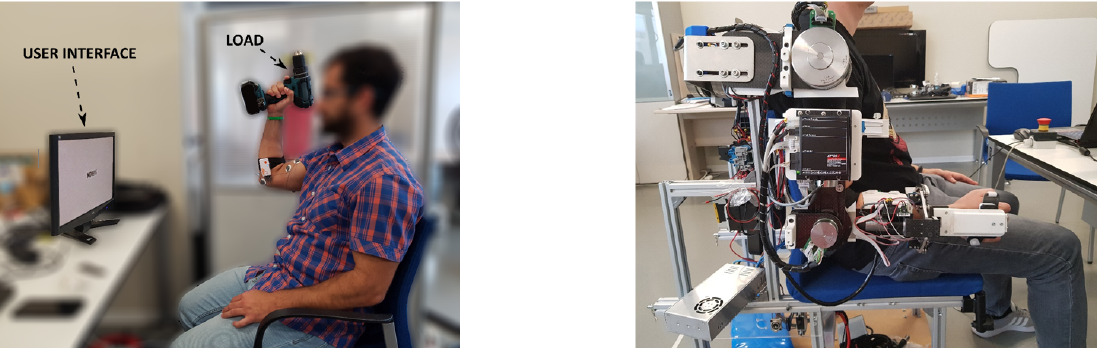
Figure 9. Experimentation setup. All the participants that appear in the figure have provided written and informed consent for its publication.